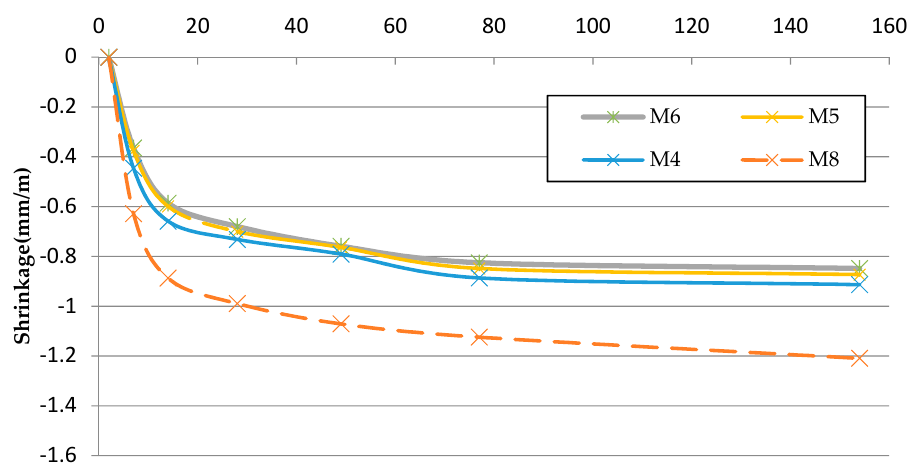
Figure 10. Drying shrinkage (Family-2 and Family-3).